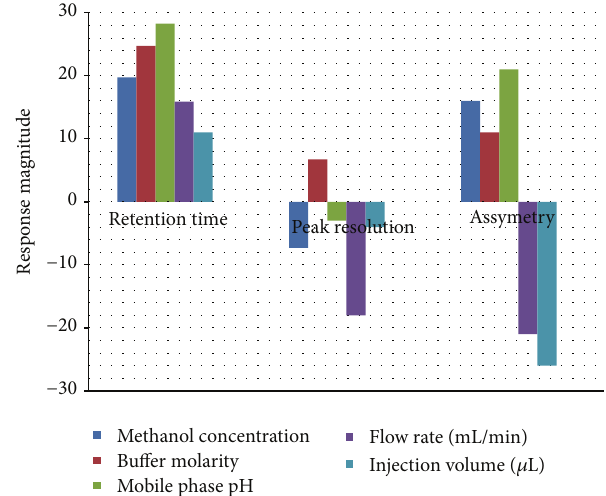
Figure 2: Influence of selected parameters on the response magni-